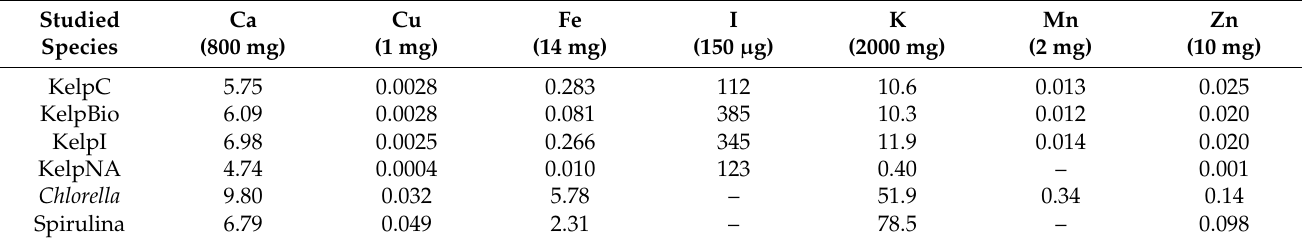
Table 6. Daily intakes for particular elements provided by the consumption of Kelp, Chlorella and Spirulina. Studied